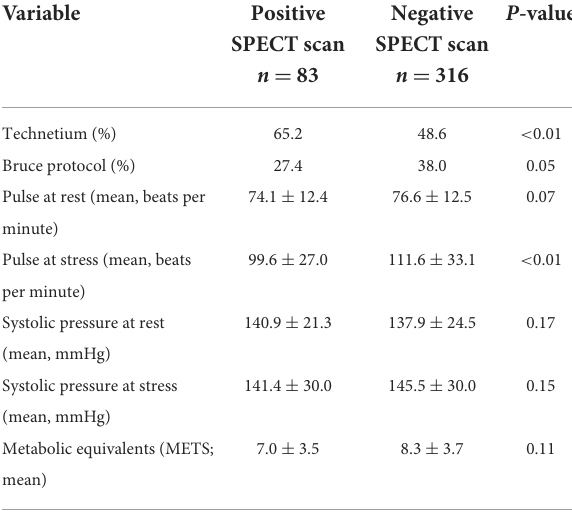
TABLE 1 Patients demographic and Baseline pre-transplant clinical characteristics according to cardiac assessment with/without SPECT scan.